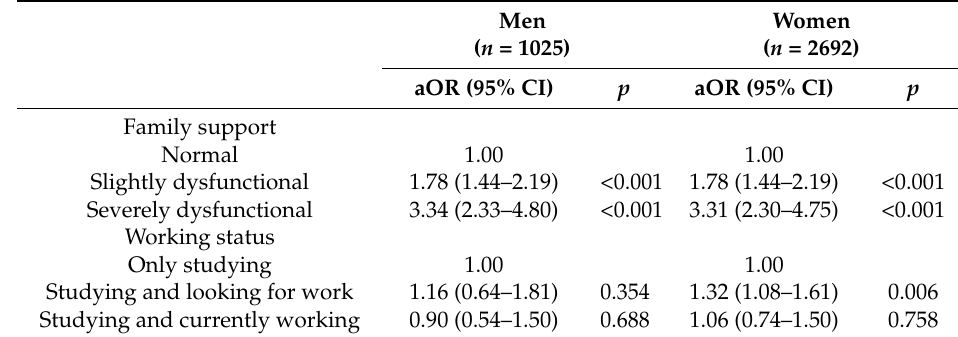
Table 3. Relationship between family support (APGAR) and working status with psychological distress by gender. Multivariate analysis. UniHcos project